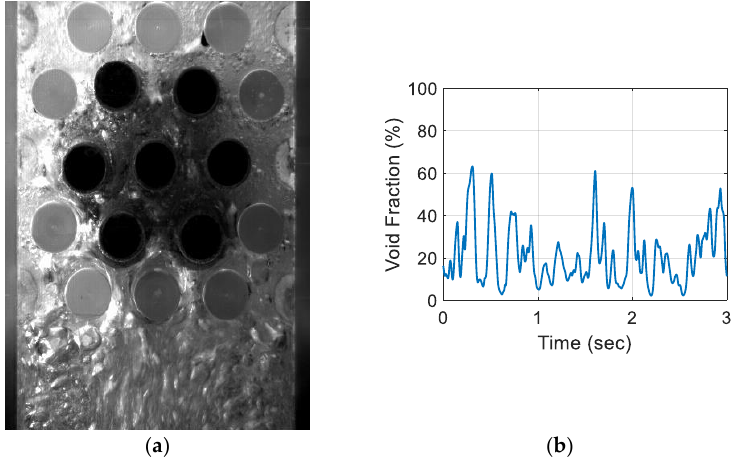
Figure 20. Experimental results for the one sensor configuration at an air flow rate of 20 L/min: ( a ) flow visualization and ( b ) void fraction signal.